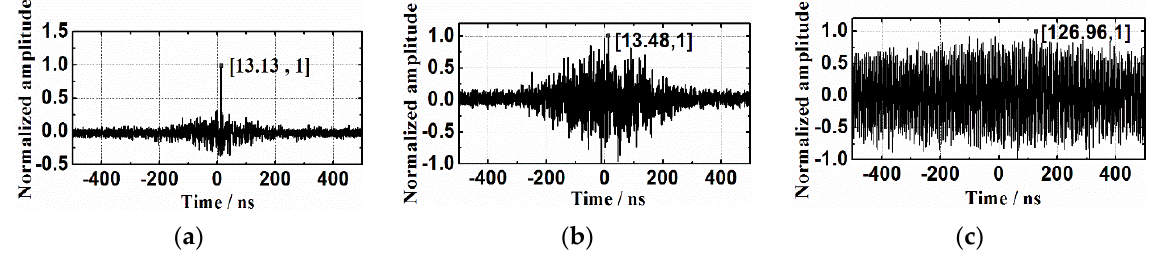
Figure 6. Comparison of time delay results using: ( a ) Method 1; ( b ) Method 2; ( c ) Method 3. N = 100; SNR with Gaussian noise = − 20 dB; narrow-band noise with frequencies of 80 MHz, 100 MHz, and 150 MHz, where the corresponding amplitudes are 0.05 V, 0.2 V, and 0.5 V, respectively, are also added.